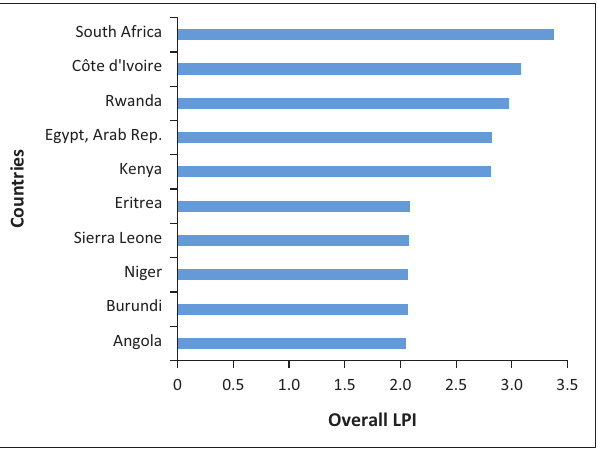
FIGURE 3: Logistics Performance Index of African countries with better and lowest logistics in